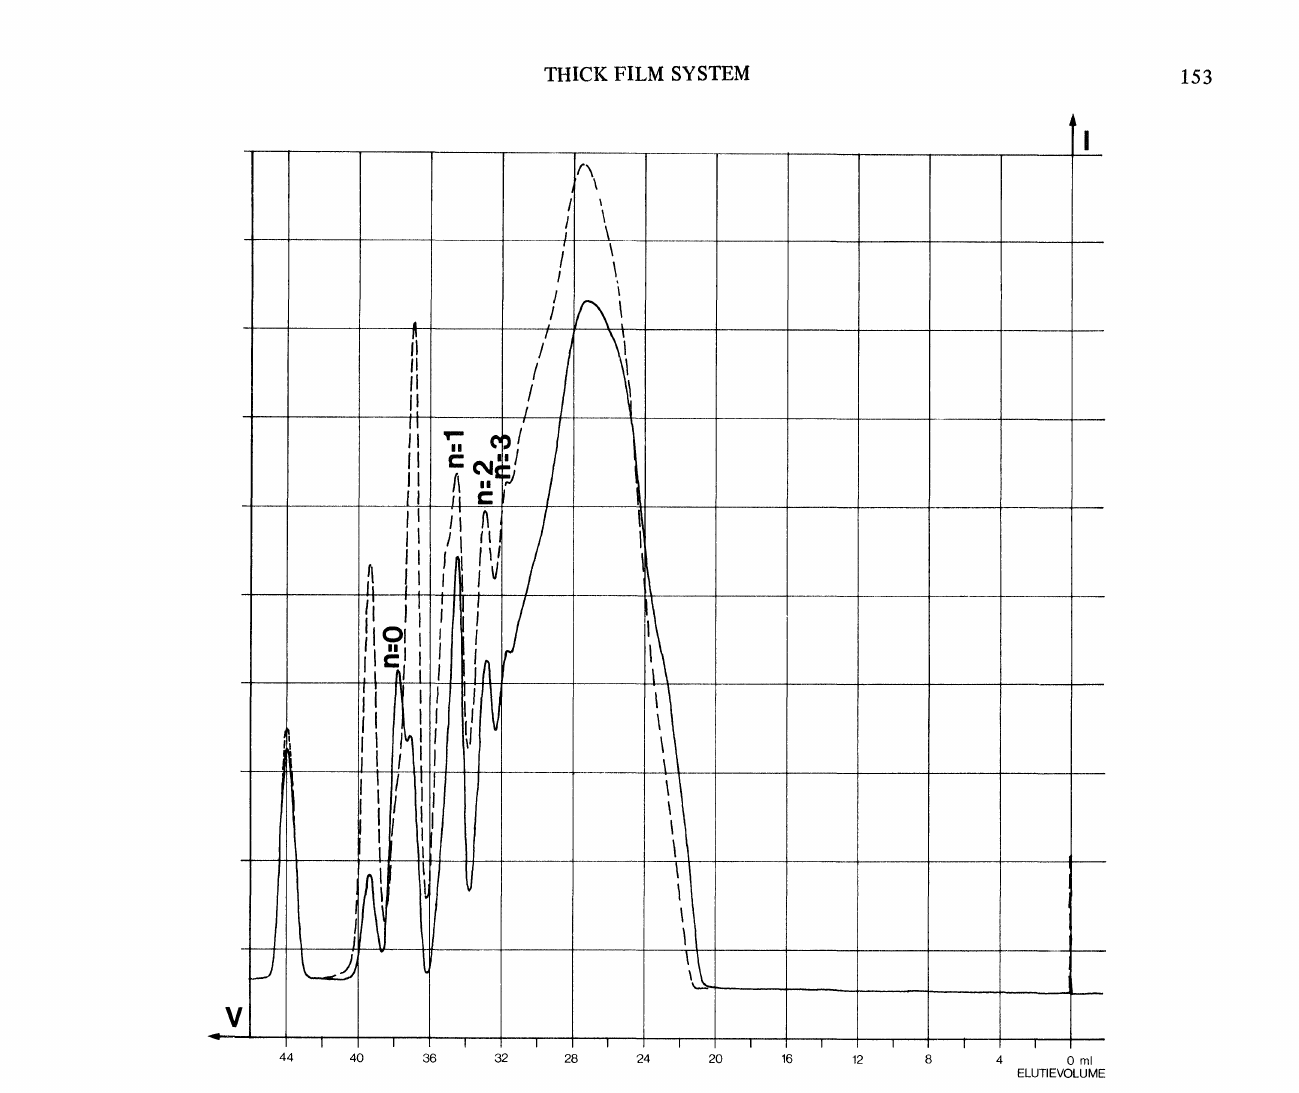
FIGURE GPC for the batches A and B discussed in Section 3.1. The peak height (UV detection) is given as a function of elutionvolume (V). The degree of polymerisation of some fractions is indicated with n.